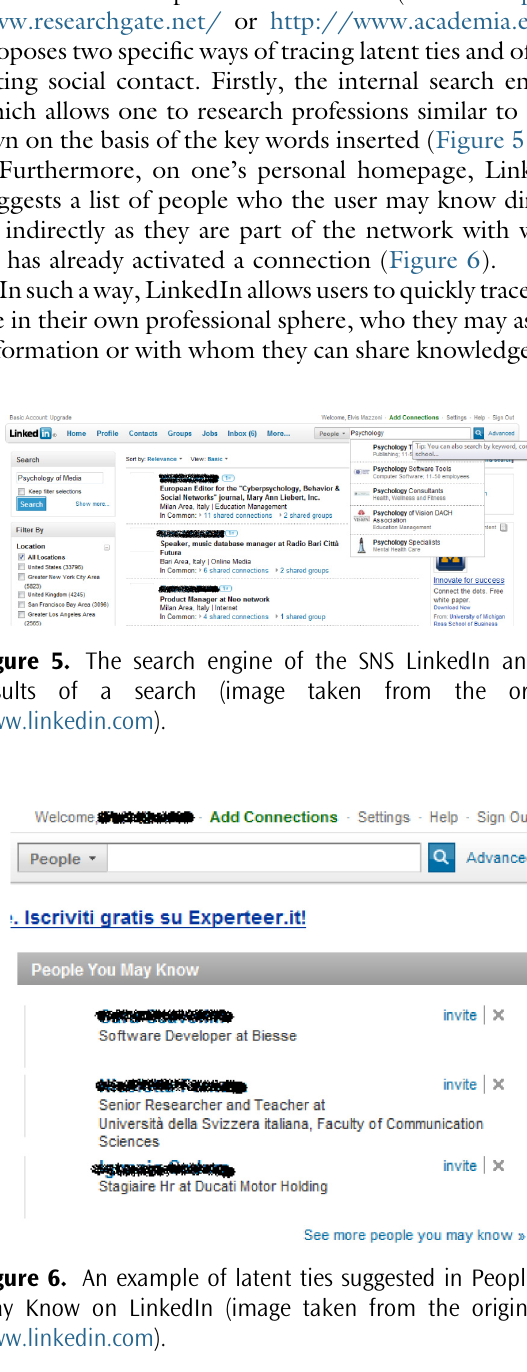
Figure 4. Student ’s search (left) and enrollment (right) in the Facebook group dedicated to the students at the Psychology Faculty in Bologna (image taken from the original on www.facebook.com).